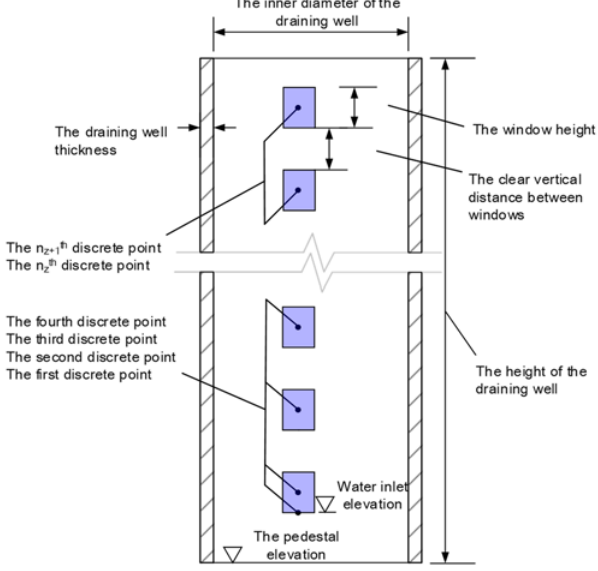
Figure 3. Water level discrete method.